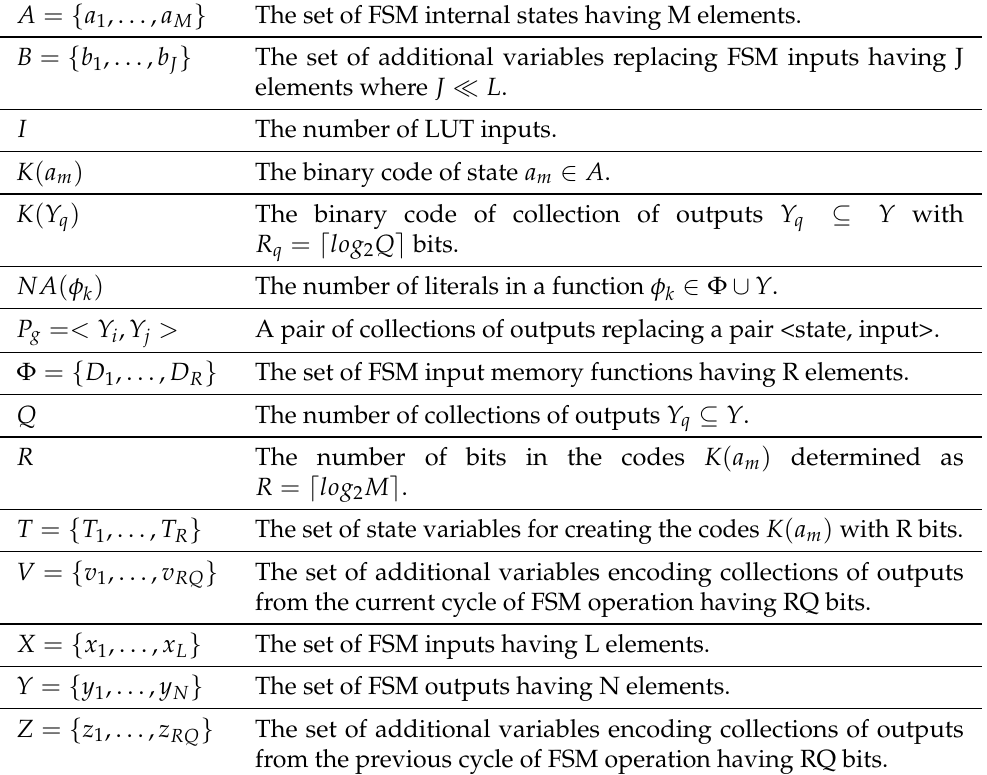
Table 1. The main notation used in the